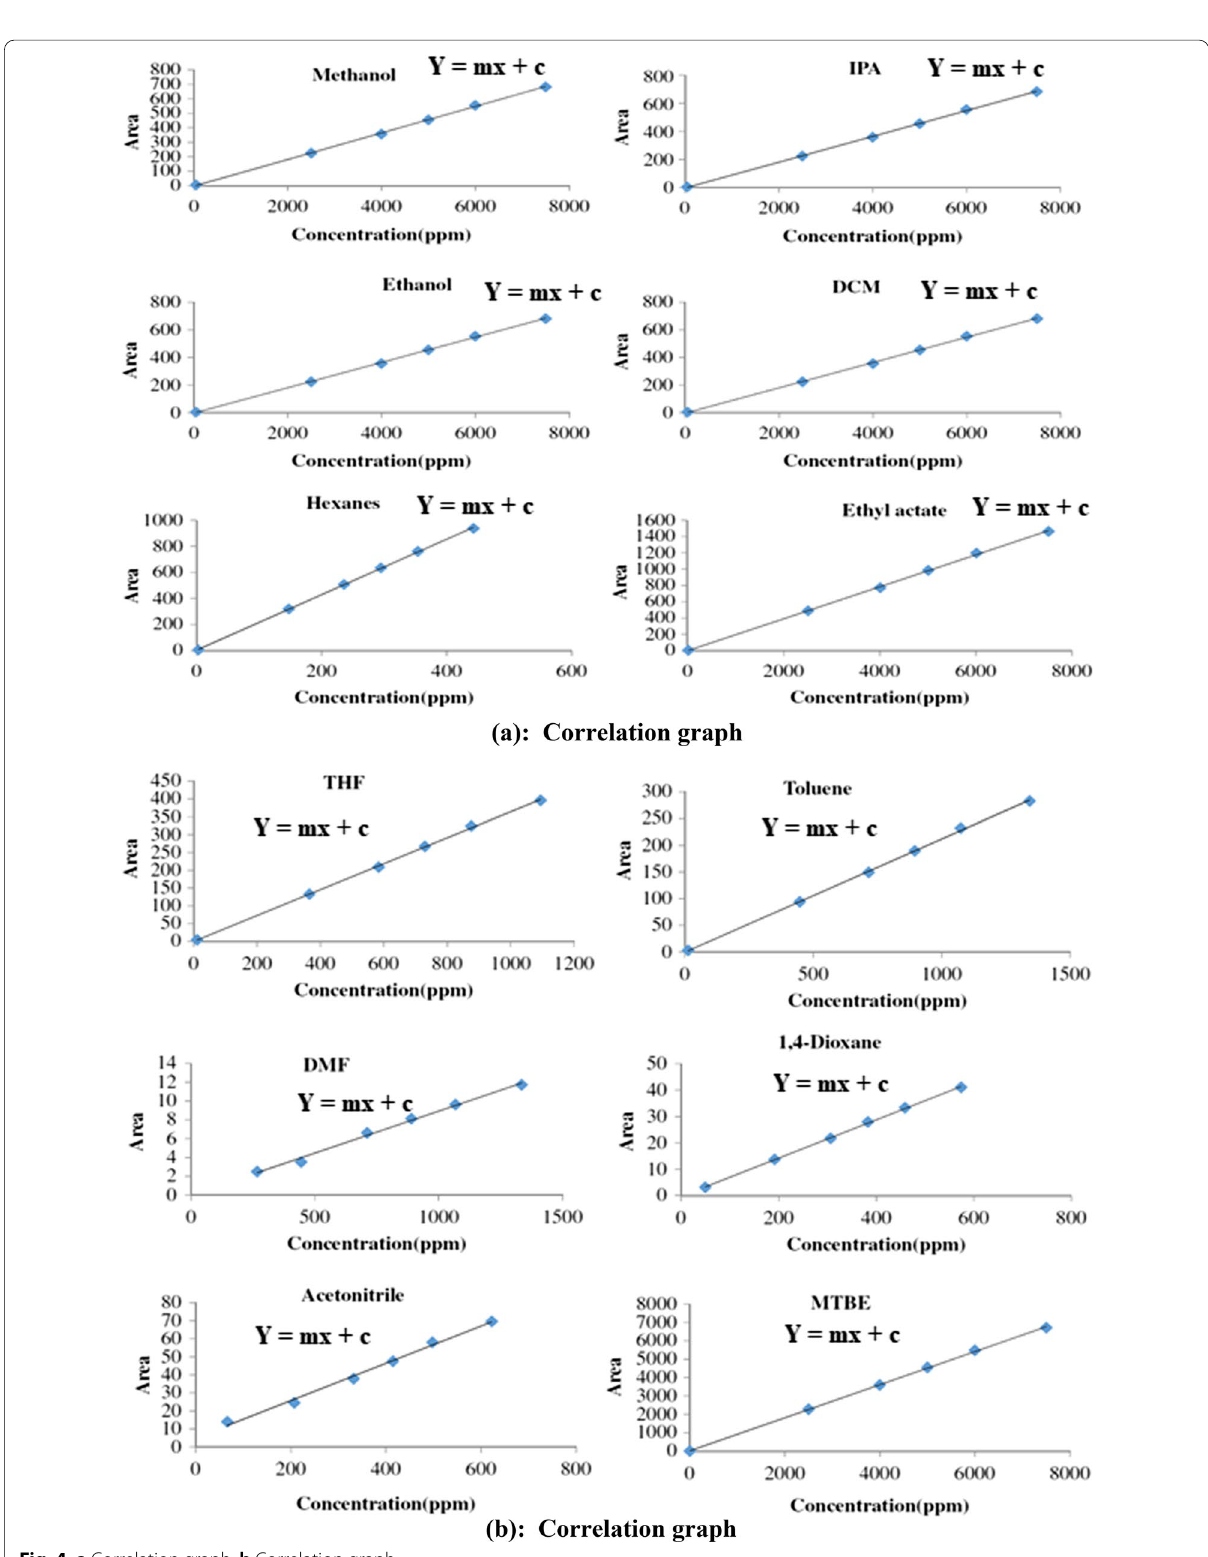
Fig. 4 a Correlation graph, b Correlation